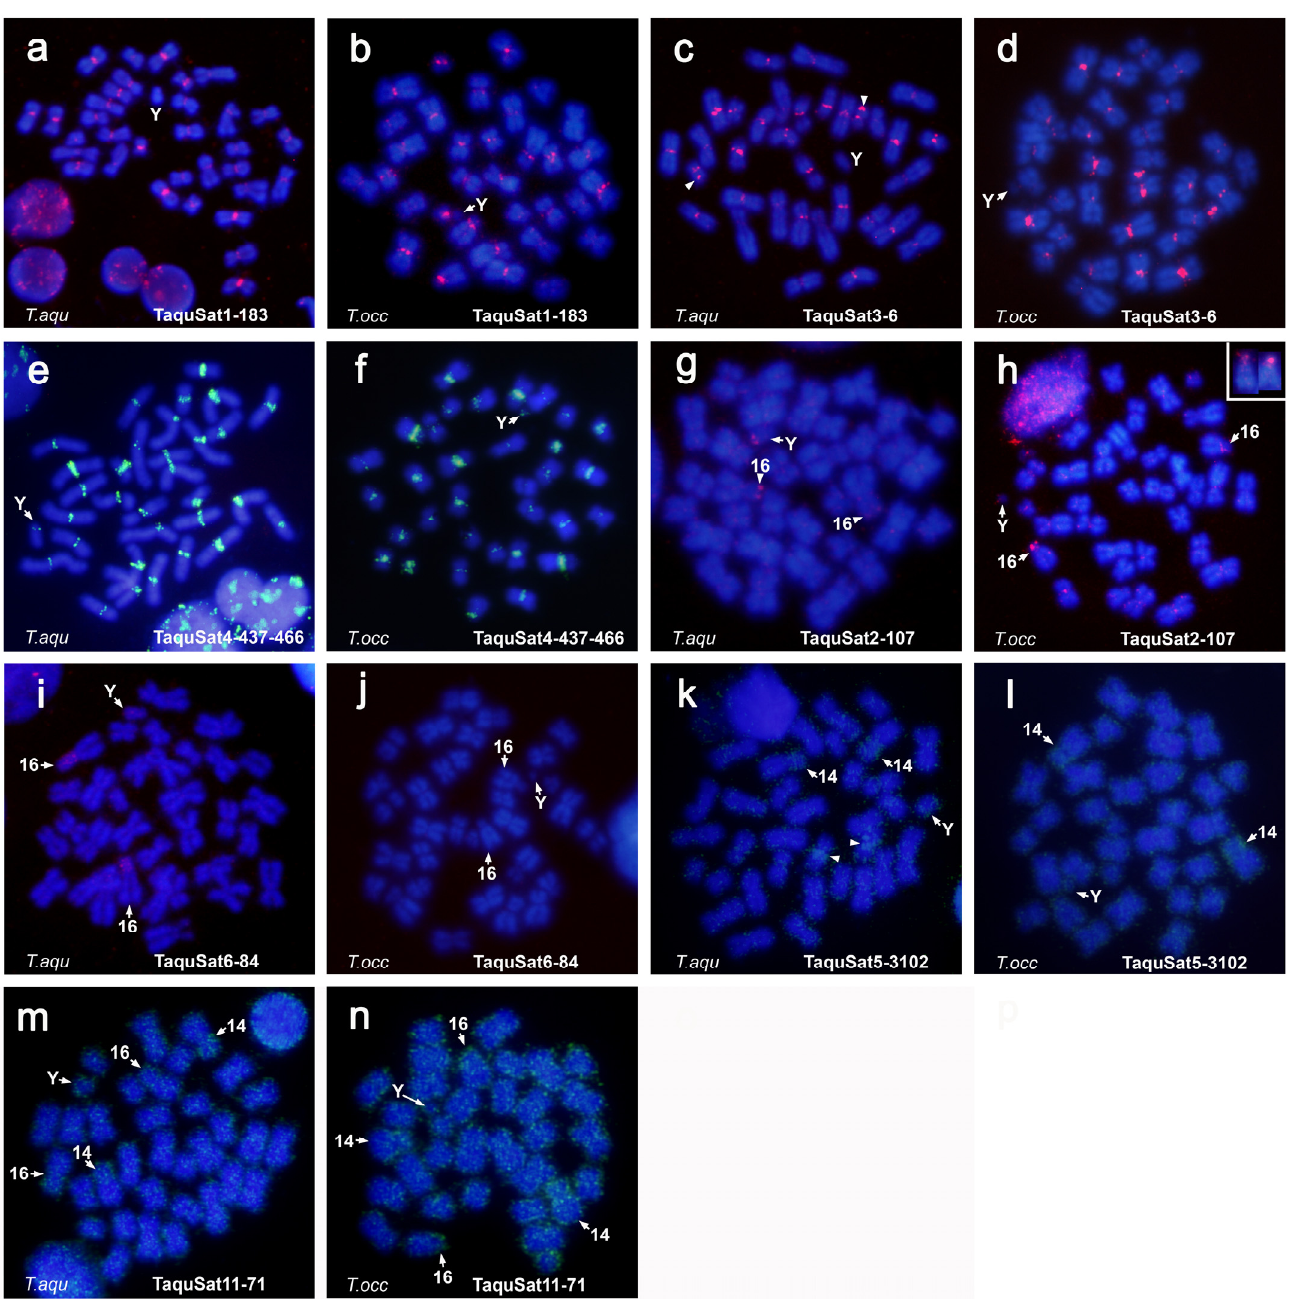
Figure 3. Male metaphases of T. aquitania ( a , c , e , g , i , k , m ) and T. occidentalis ( b , d , f , h , j , l , n ) hybridized with satDNA probes: ( a , b ): TaquSat1-183; ( c , d ): TaquSat3-6; ( e , f ): TaquSat4-437-466; ( g , h ): TaquSat2- 107; ( i , j ): TaquSat6-84; ( k , l ): TaquSat5-3102; ( m , n ): TaquSat11-71. Arrowhead denotes the interstitial signal on the small autosome pair in ( c ), accumulation of signal on the centromeric region of one autosome pair in ( k ). Insert in ( h ), pair 16 chromosomes from other metaphase hybridized with the same